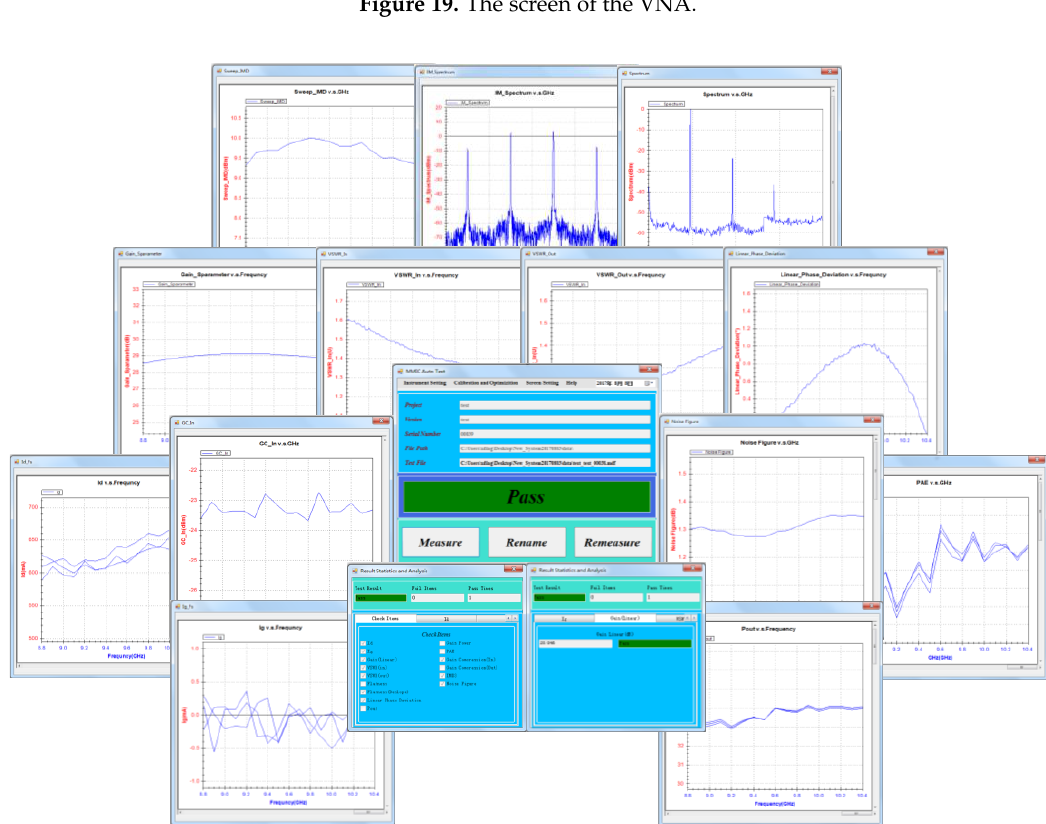
Figure 20. The windows of the measurement results.